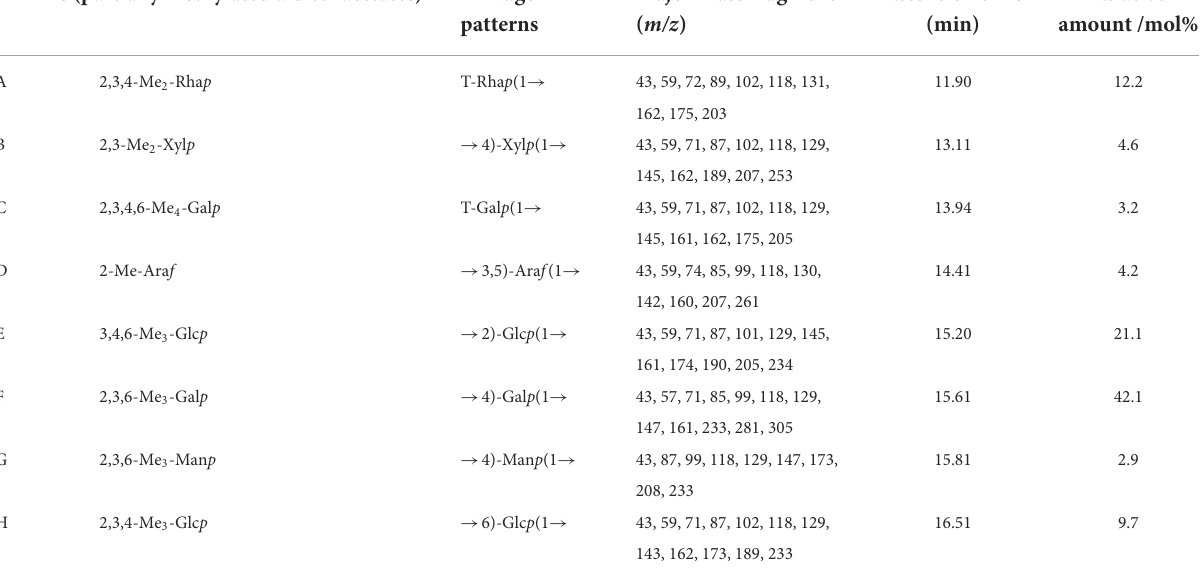
TABLE 2 Methylation analysis result of SHP-2. PMAAs (partially methylated alditol acetates) Linkage